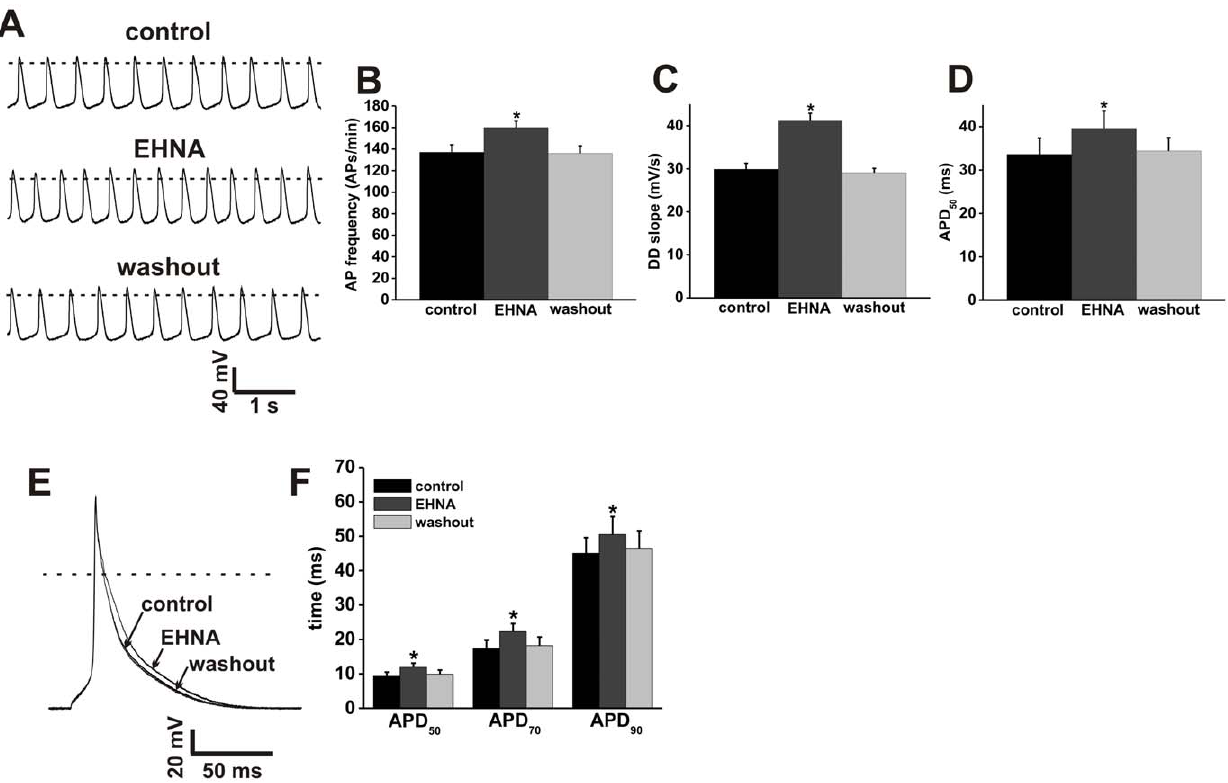
Figure 3. Effects of the PDE2 inhibitor EHNA on action potential firing in SAN and atrial myocytes. A. Representative spontaneous AP recordings (5 s duration) in control conditions, in the presence of EHNA (10 m M) and after EHNA washout. Dotted lines are at 0 mV. Summary bar graphs illustrate the effects of EHNA on spontaneous AP frequency ( B ), DD slope ( C ) and APD 50 ( D ). E. Representative stimulated right atrial myocyte APs in control conditions, in the presence of EHNA (10 m M) and after EHNA washout. Dotted line is at 0 mV. F. Summary of the effects of EHNA on atrial AP duration (APD 50 , APD 70 , and APD 90 ). Summary data are means 6 SEM; n =6 SAN myocytes and 7 right atrial myocytes; * P , 0.05 vs. control by one way ANOVA with Tukey’s posthoc